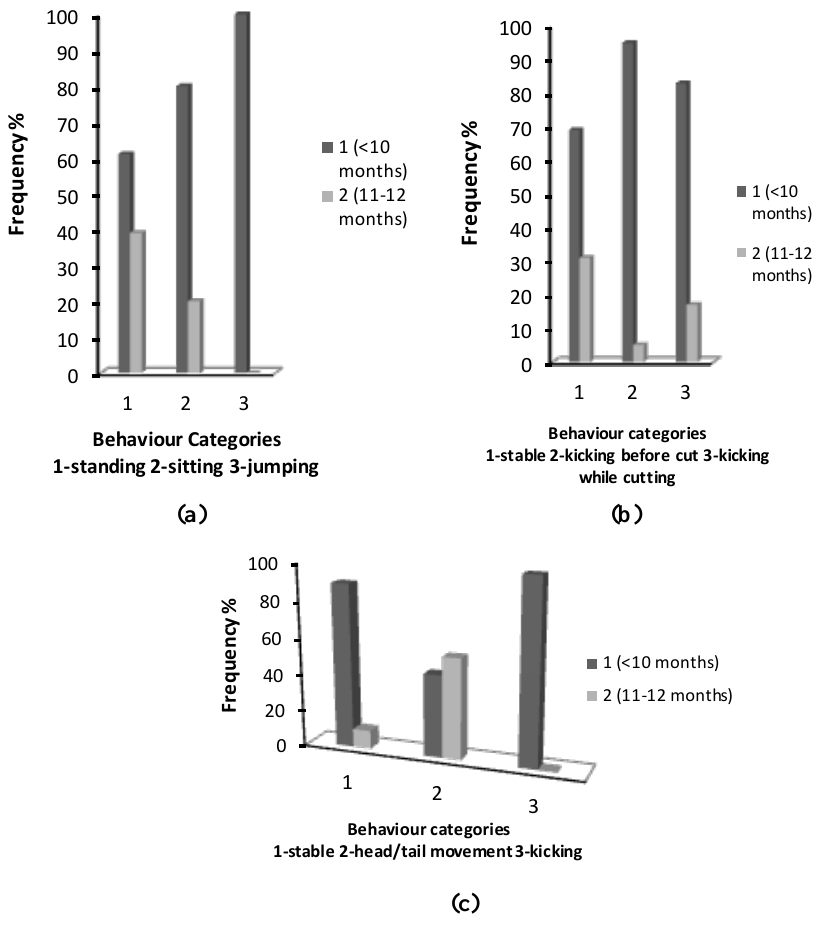
Figure 2. Frequencies of age groups in animal avoidance-related behaviour categories before and after stunning, and during bleeding. to the extra production role played by the female animals in